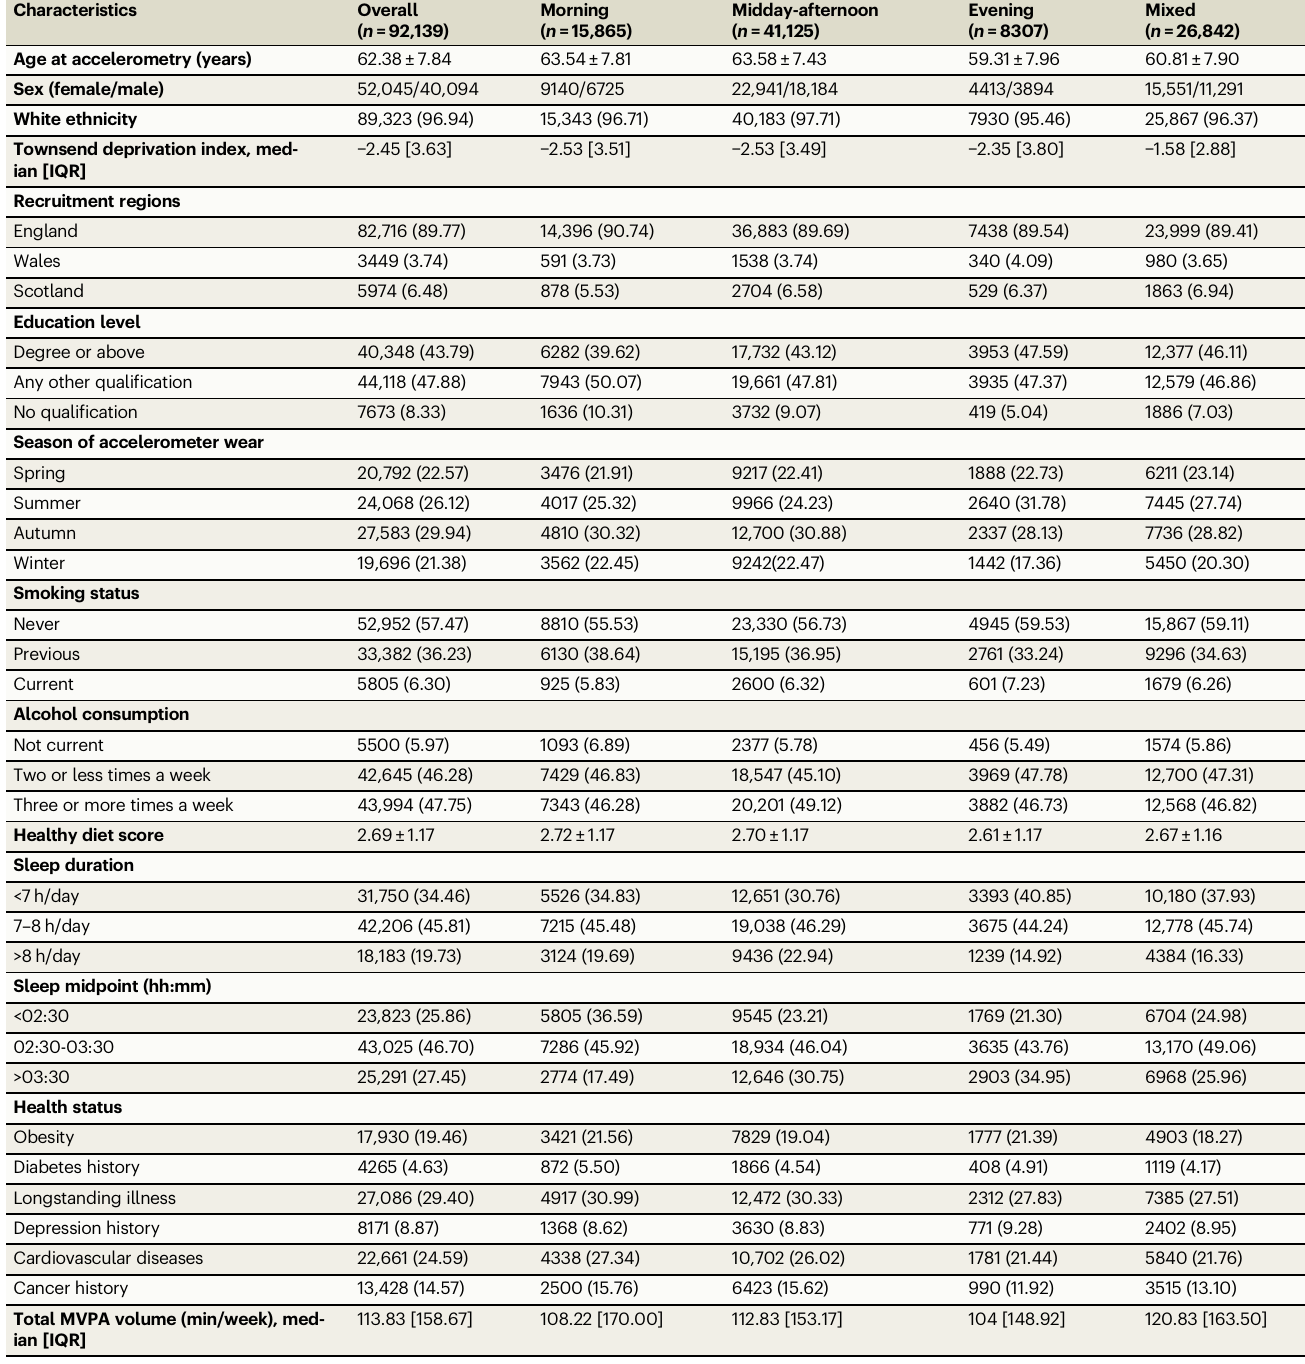
Table 1 | Baseline characteristics of the study participants